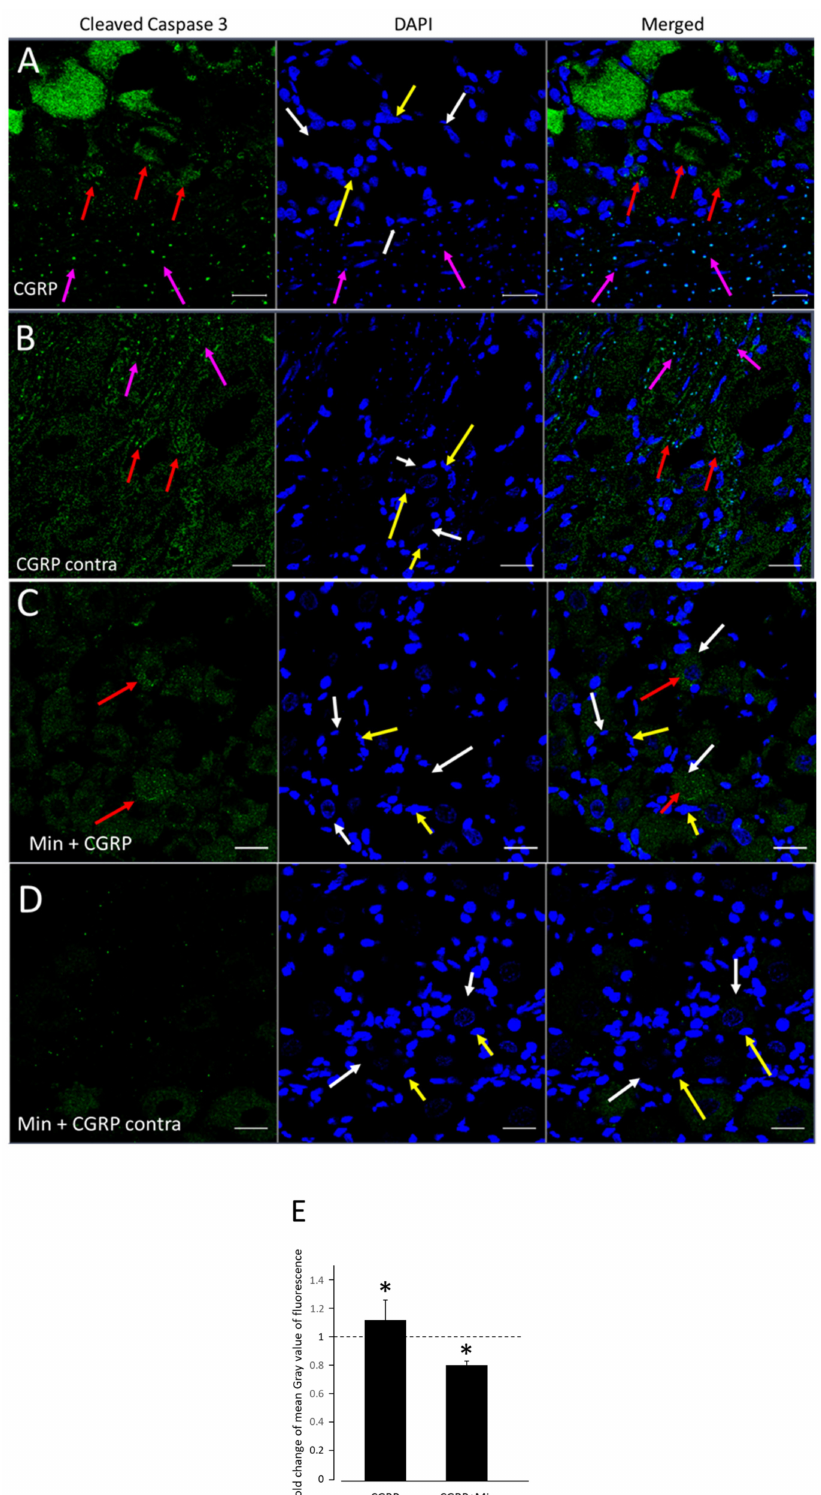
Figure 4. Following the NF- κ B signaling pathway gene analyses, where fold regulation of Casp8 was found to be increased after CGRP stimulation, change in expression of cleaved Caspase-3 (cleav Casp3) in sections from TG was observed in the animals after IG administration of CGRP and Min + CGRP compared to non-injected ganglion. Confocal images of immunofluorescent staining of TG sections with cleav Casp3 (green immunofluorescence), and 4 (cid:48) ,6-Diamidino-2-phenylindole